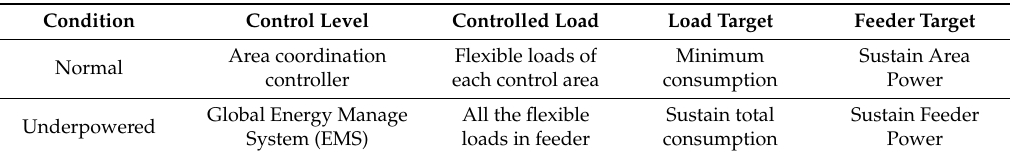
Table 2. ADN flexible load control